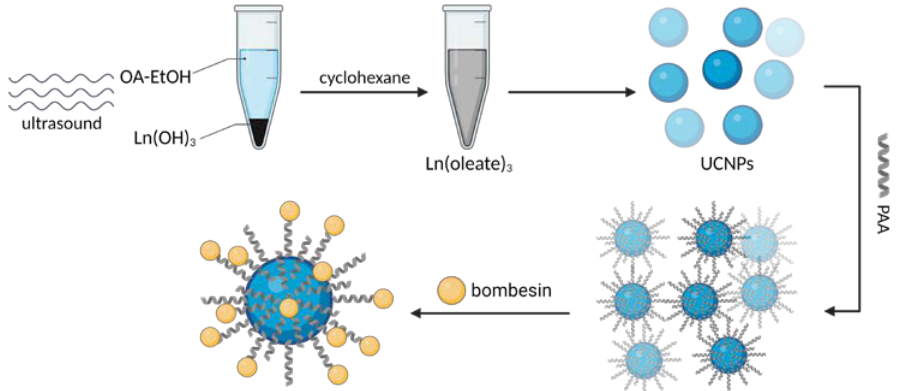
Figure 18. The synthesis of PAA-coated, BBN-labelled upconversion nanoparticles (UCNPs) using lanthanide oleate as the precursor (inspired by [49]). Created with BioRender.com.